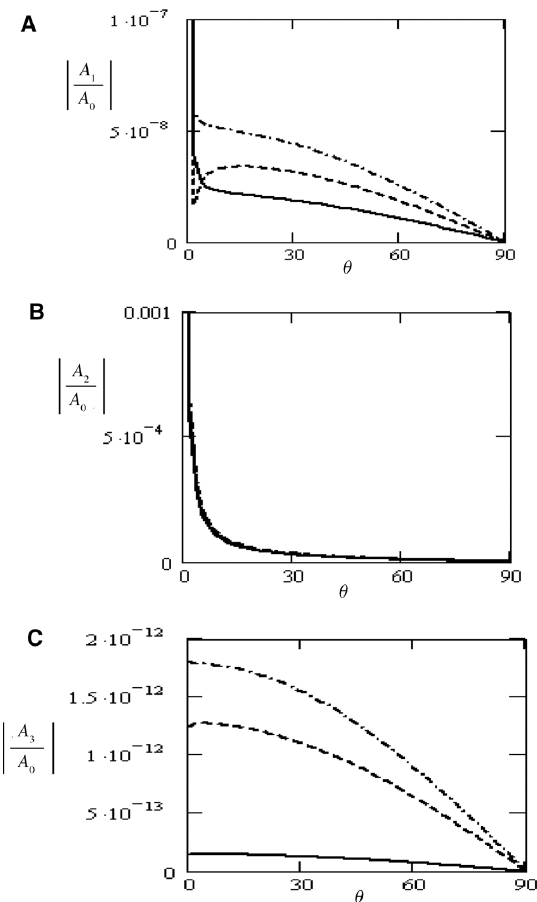
Figure 3: Variations of initial stress P = 10 10 ___, 2(10 10 ) – . – ., 3(10 10 ) – – – on the magnitude of amplitude ratios with respect to the angle of